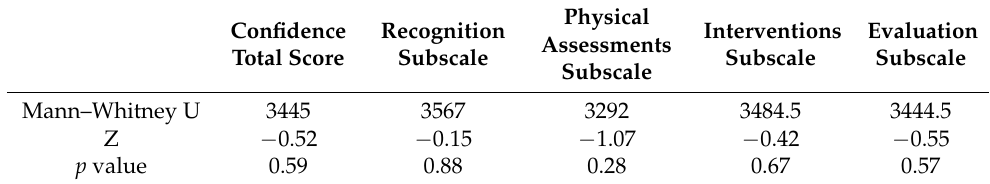
Table 5. Differences in professional self-confidence and its subdimensions based on exposure to COVID-19 patients.